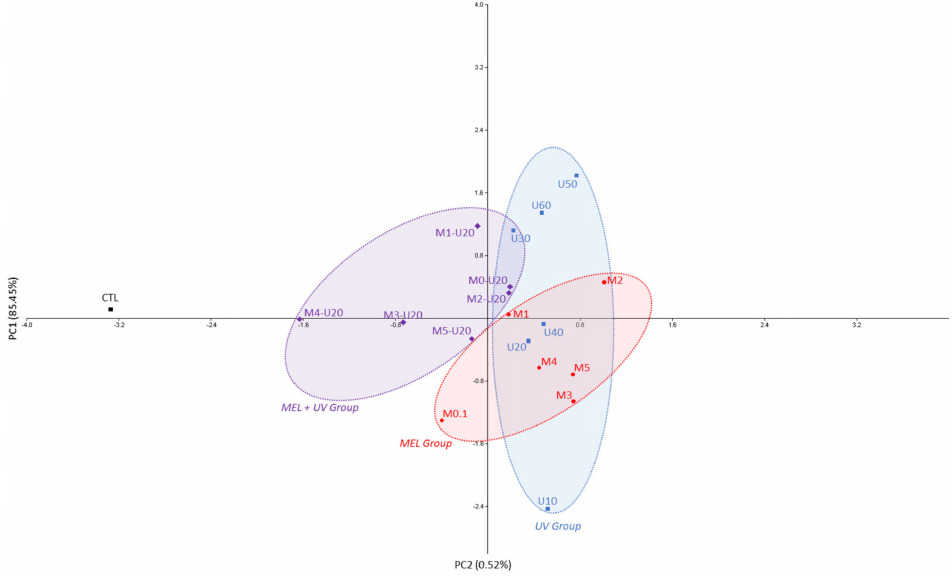
Figure 5. Principal component analysis (PCA) showing the impact of melatonin (MEL), UV-C (UV) and their combination on the phytochemical and antioxidant capacities of purple basil calli extracts. Variance of factor 1 (F1) = 85.45% and of factor 2 (F2) =